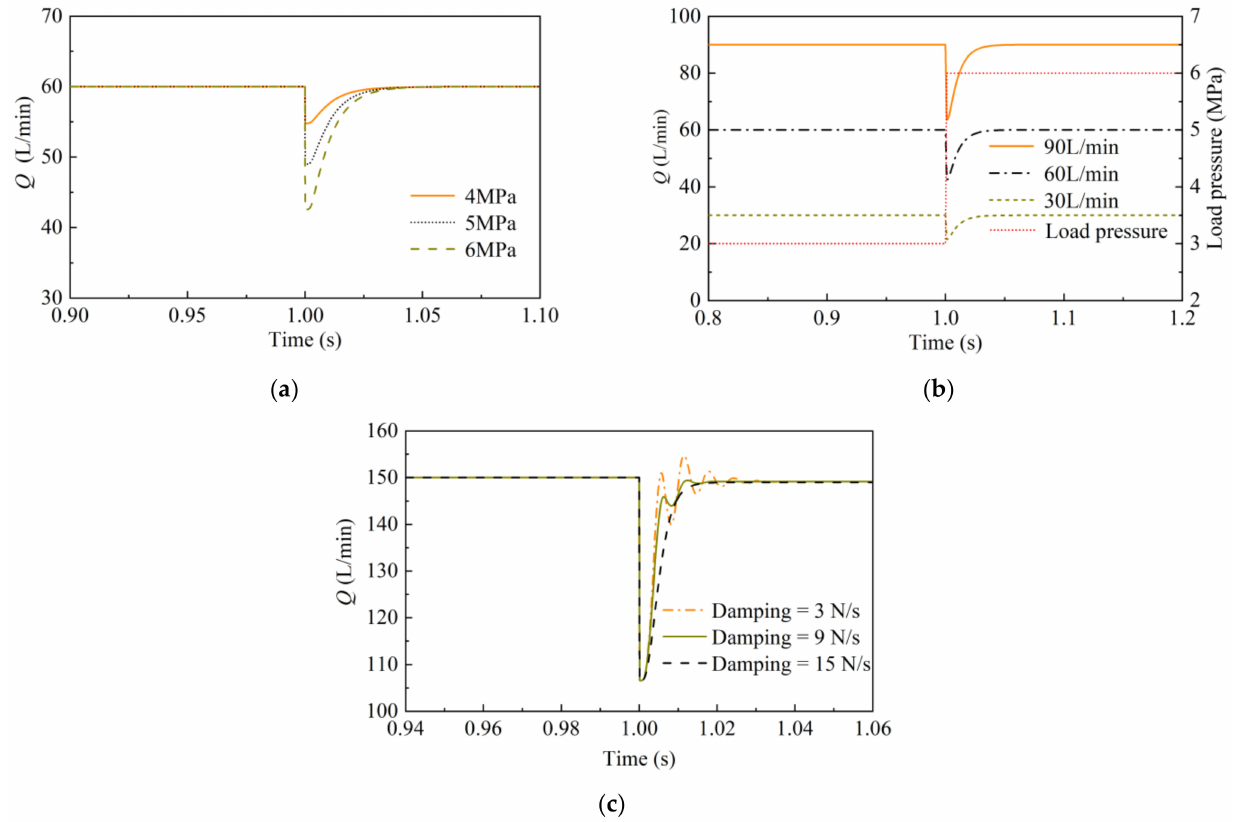
Figure 13. Load step response curve. ( a ) Effect of different load steps on the flow rate; ( b ) effect of load steps on different flow rates; ( c ) load step with different damping.